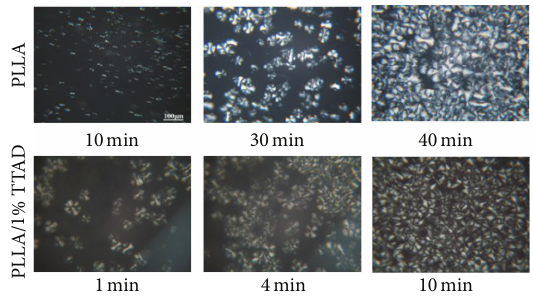
Figure 7: POM images of PLLA and PLLA/1% TTAD during isothermal crystallization process at 105 ∘ C.